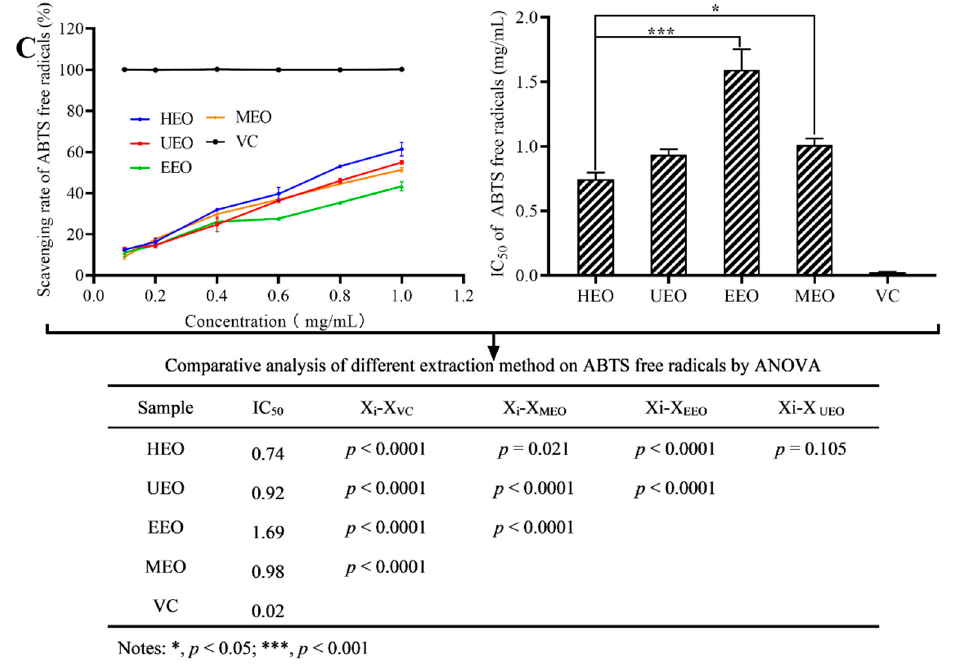
Figure 7. Free radical scavenging activities of EOs, ( A ) is DPPH free radicals, ( B ) is hydroxyl free radicals, ( C ) is ABTS free radicals.